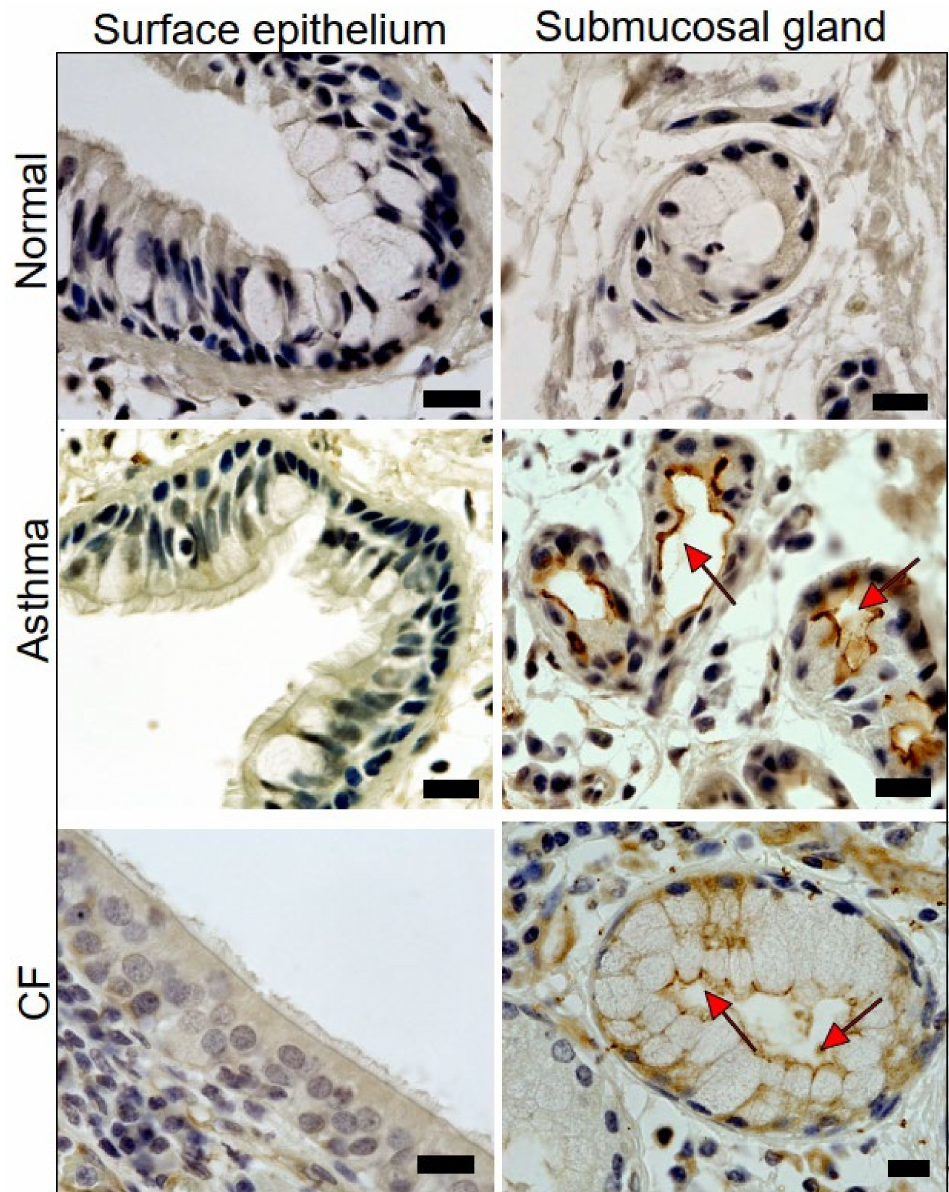
Figure 1. Expression of TMEM16A in human healthy, asthmatic, and CF lungs. Lung slices of normal airways indicate little expression of TMEM16A in both surface airway epithelium and airway submucosal glands. Pronounced expression of TMEM16A in apical membranes of surface epithelial cells and airway submucosal glands of patients with asthma and CF (brown precipitation, DAP staining). Submucosal glands were often found to be hypertrophic. Representative stainings of four patients each. Bars indicate 20 µ